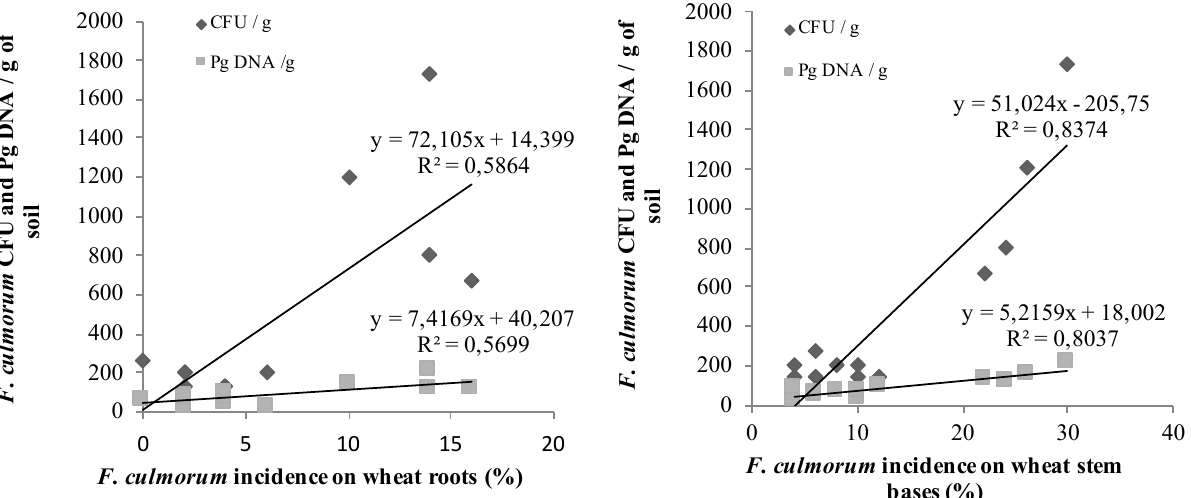
Figure 7. Correlations (Pearson’s correlation test) between Fusarium culmorum on wheat roots (A) and stem bases (B) and amounts of F. culmorum inoculum left in the soil after 1 year at the Bou Salem experimental trial, as analyzed by soil dilution plating and quantitative real-time polymerase chain reaction